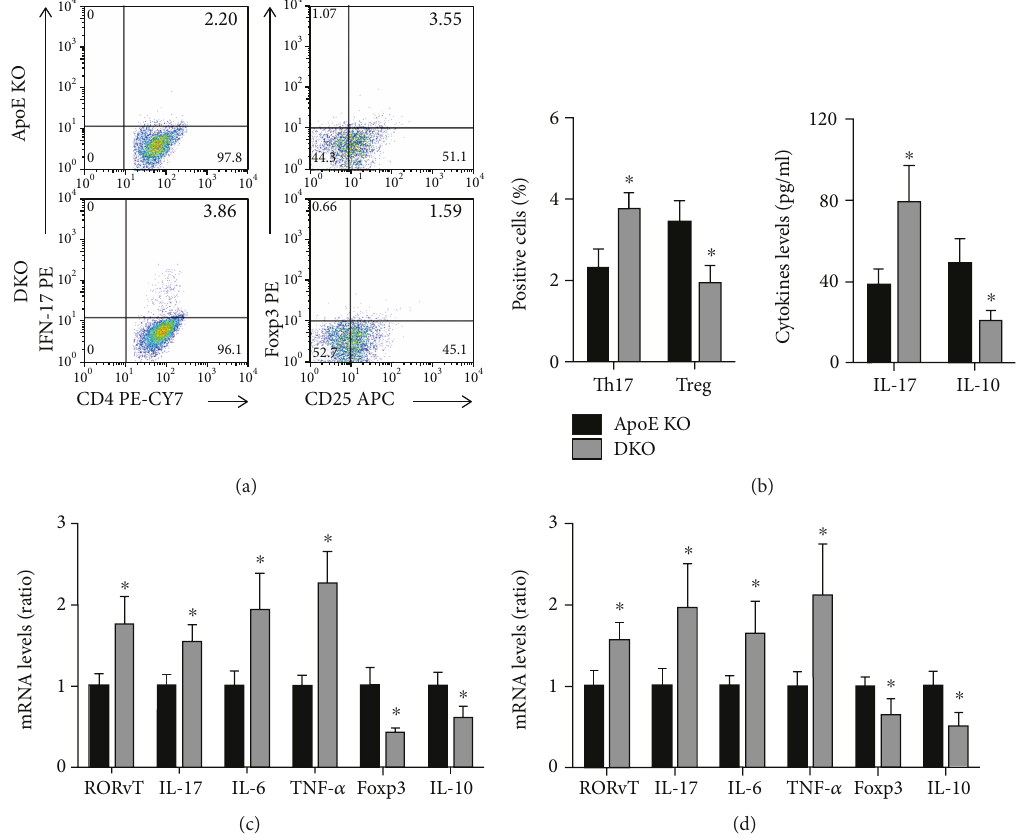
Figure 4: E ff ect of IL-12p35 de fi ciency on the activity of Th17 and Treg. (a) The frequency of Th17 and Treg in ApoE-/- mice and ApoE-/- IL-12p35-/- mice was measured by fl ow cytometry; n = 10 for each group. (b) The serum IL-17 and IL-10 levels were detected by ELISA; n = 16 for each group. (c, d) The mRNA levels of ROR γ T, IL-17, IL-6, TNF- α , Foxp3, and IL-10 in the spleens and aortas of these two groups were analyzed by RT-qPCR. ApoE KO=ApoE-/-, DKO=ApoE-/- IL-12p35-/-; N = 6 for each group. ∗ P < 0 05 vs. the ApoE-/-group. Table 3: Lipid pro fi le of serum and body weight of ApoE-/-+PBS and ApoE-/-+rIL-35 mice. ApoE